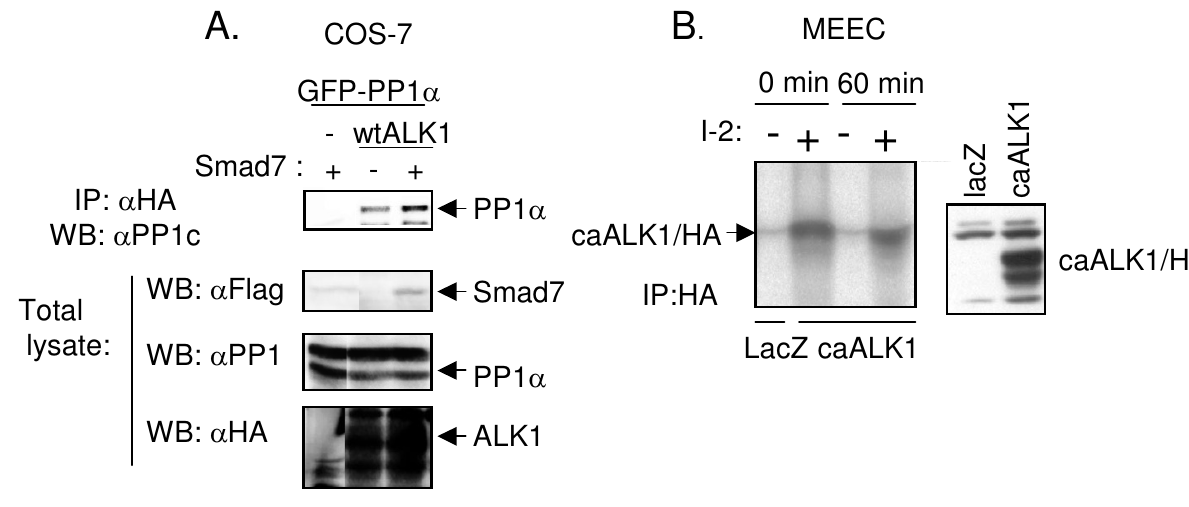
Figure 5 Smad7 recruits PP1 α to ALK1. (A) COS-7 cells were transfected with eGFP-PP1 α , wtALK1/HA and/or Flag-Smad7. After 48 h at 37°C, cells were lysed. Whole cell lysates were immunoprecipitatedwith HA antibody, fractionated by SDS-PAGE, and subjected to immunoblotting with PP1c antiserum. Total lysates were fractionated by SDS-PAGE and subjected to immunob- lotting with antisera against Flag, PP1 and HA to check expression levels. ( B ) Left panel . Phosphatase inhibition assay. MEECs were adenovirally infected with the indicated constructs and immunopreciptated with HA antibody. Kinase assay was per- formed with 2.5 µ Ci of [ 32 P] γ ATP per sample at 30°C for 30 min. Samples were washed in lysis buffer before they were incu- bated in a phosphatase buffer with or without the PP1 inhibitor, I-2 at 37°C for 60 min. The samples were separated by SDS- PAGE and phosphorylation quantified using phosphoimager. Right panel . Fraction of the total lysate was immunoblotted with HA antiserum to check expression levels of the